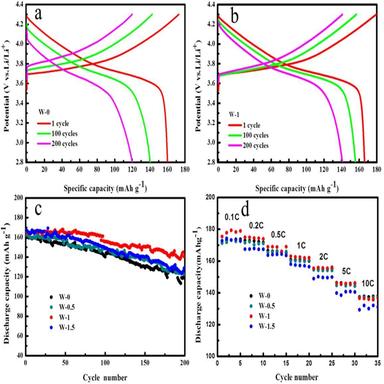
The charge and discharge curves under different cycles of W-0 (a)and W-1(b);The cycling performances(c) of various amounts of WO3-coated cathode at current density of 1 C and the corresponding rate capabilities (d) in voltage range of 2.8–4.3 V.